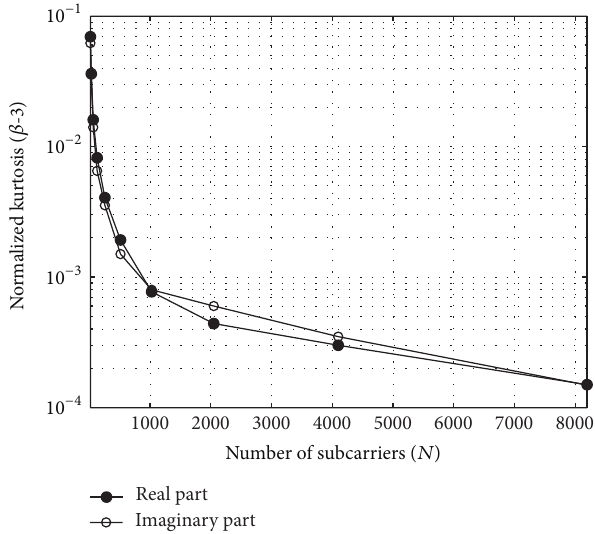
Figure 4: Normalized kurtosis ( 𝛽 - 3 ) versus subcarrier number ( N ) of the FBMC signal using 16-QAM.